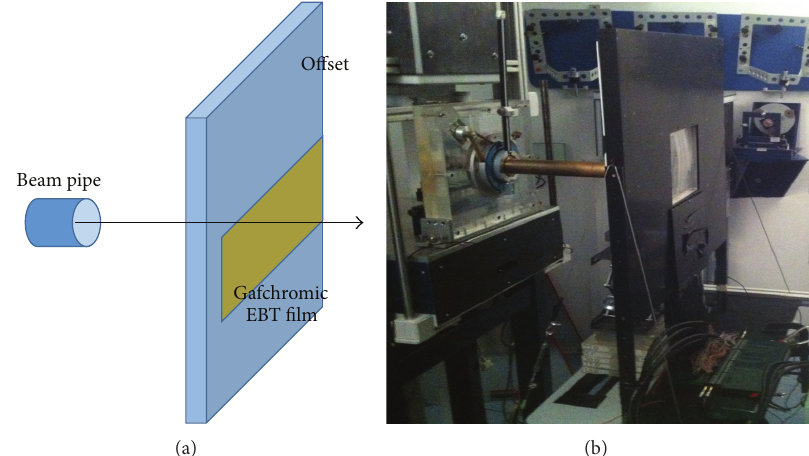
Figure 19: Drawing (a) and picture (b) of the experimental setup inside the CATANA hadrontherapy facility.